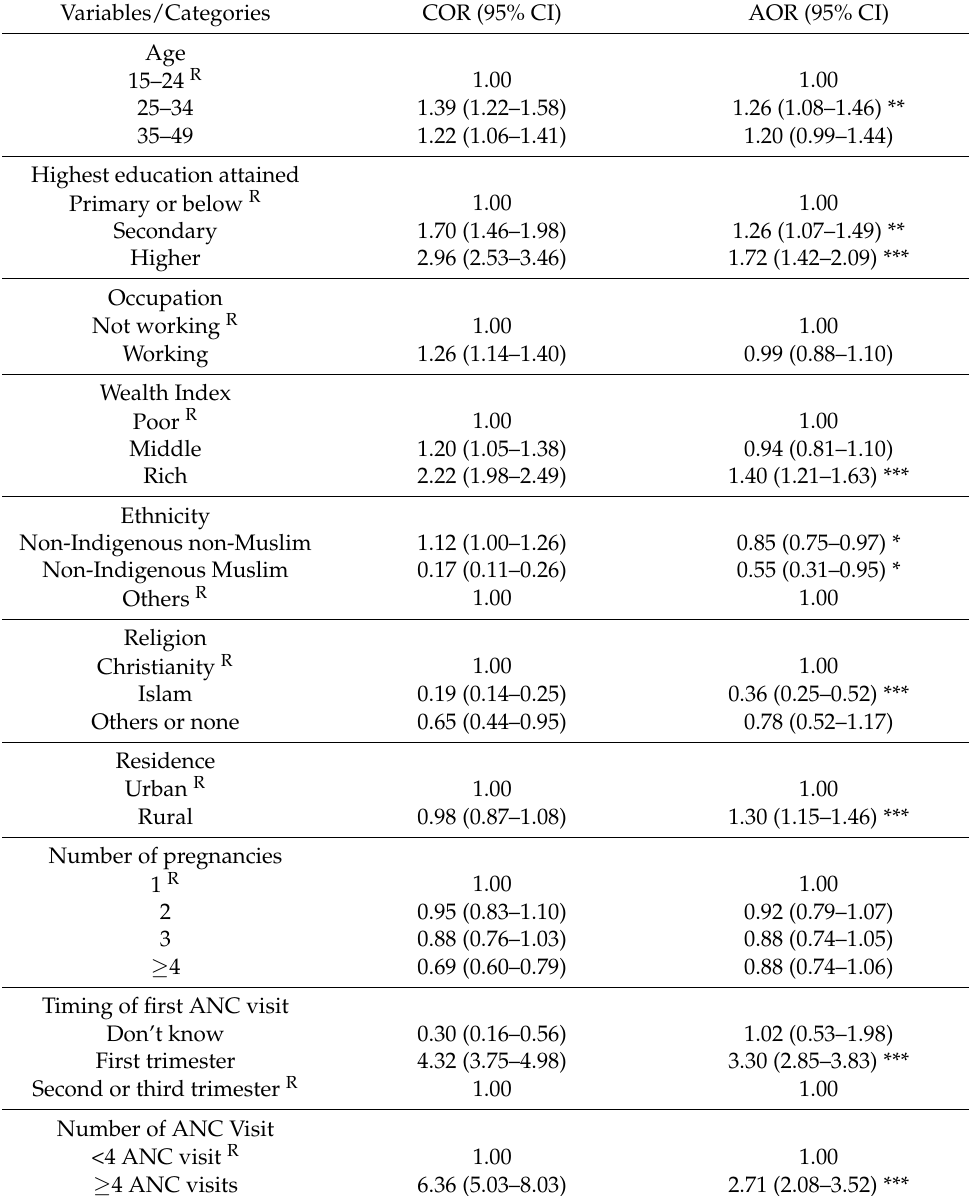
Table 2. Factors associated with compliance with iron-folic acid supplementation